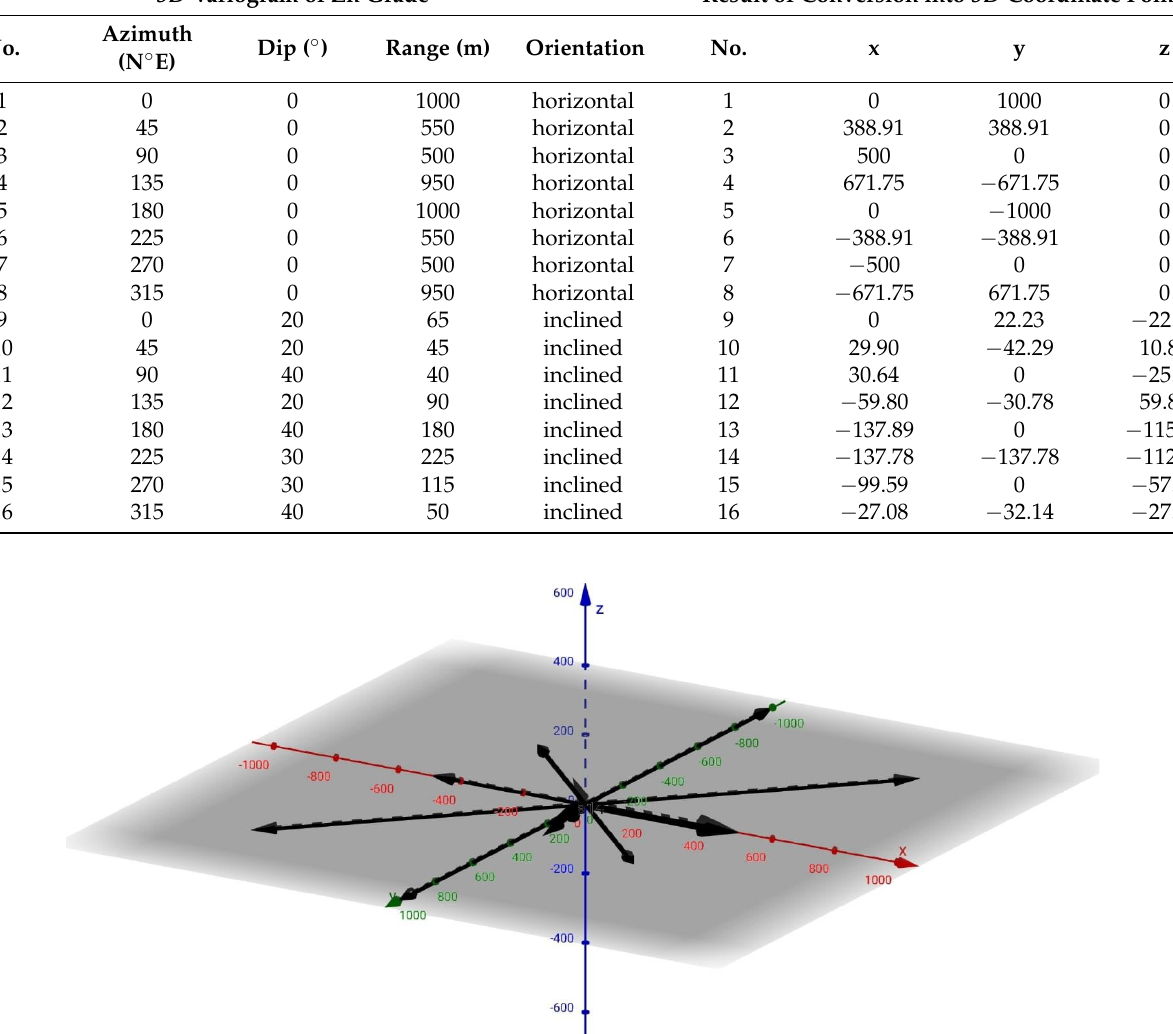
Table 1. Result of 3D variogram fitting parameters and their position in q Cartesian coordinate system. 3D Variogram of Zn Grade Result of Conversion into 3D Coordinate Points